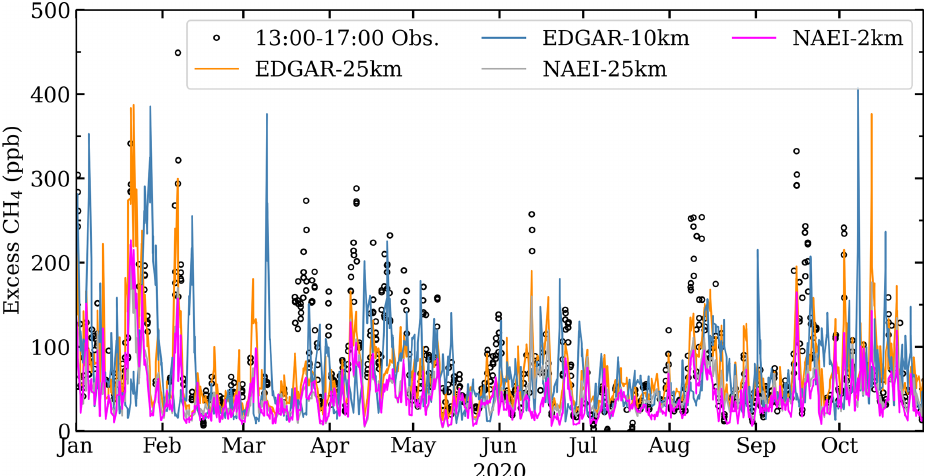
Figure 9. Excess simulated and observed 13:00–17:00 mole fractions for 2020 in which the Mace Head background has been subtracted from the ICL measurements.